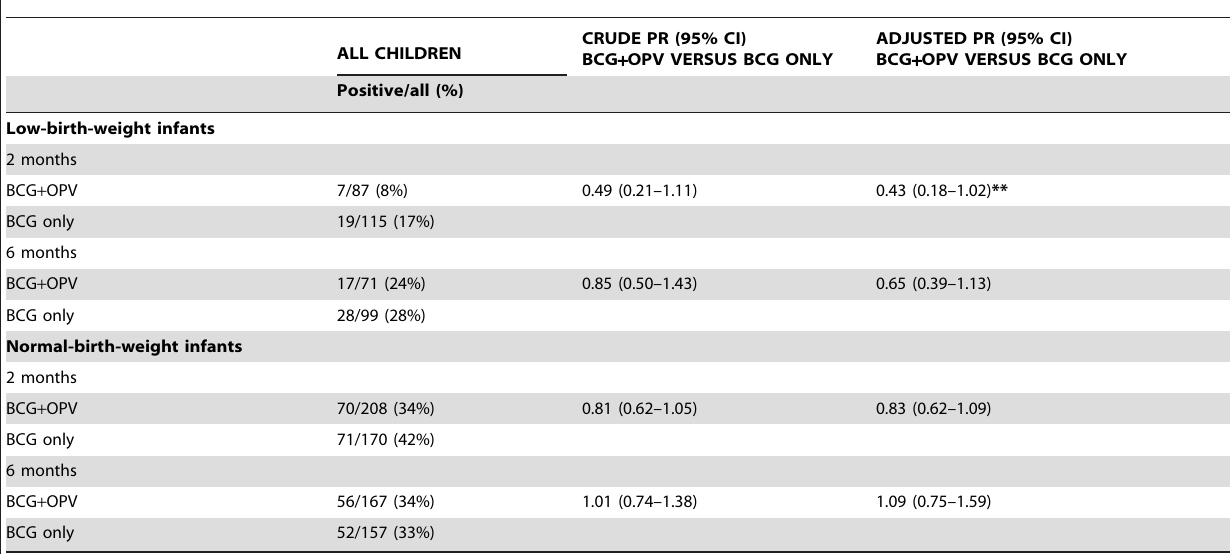
Table 4. The effect of receiving OPV with BCG at birth on the likelihood of having an in vivo response to PPD at age 2 months and 6